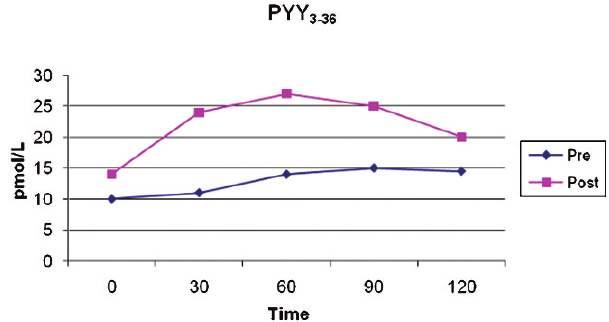
Figure 2 - Mean levels of PYY at fasting and 30, 60, 90, and 120 minutes after a standard meal, pre- and postoperatively. * p , 0.005.